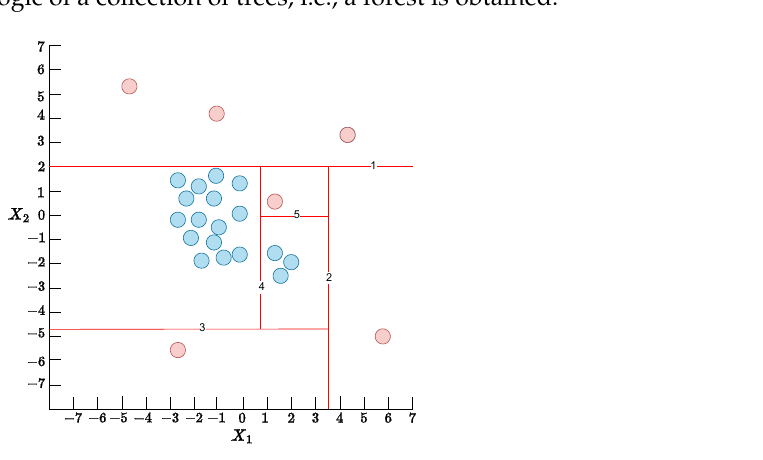
Figure 2. An example of the process that occurs in an isolation tree building to isolate points in a two-dimensional sample